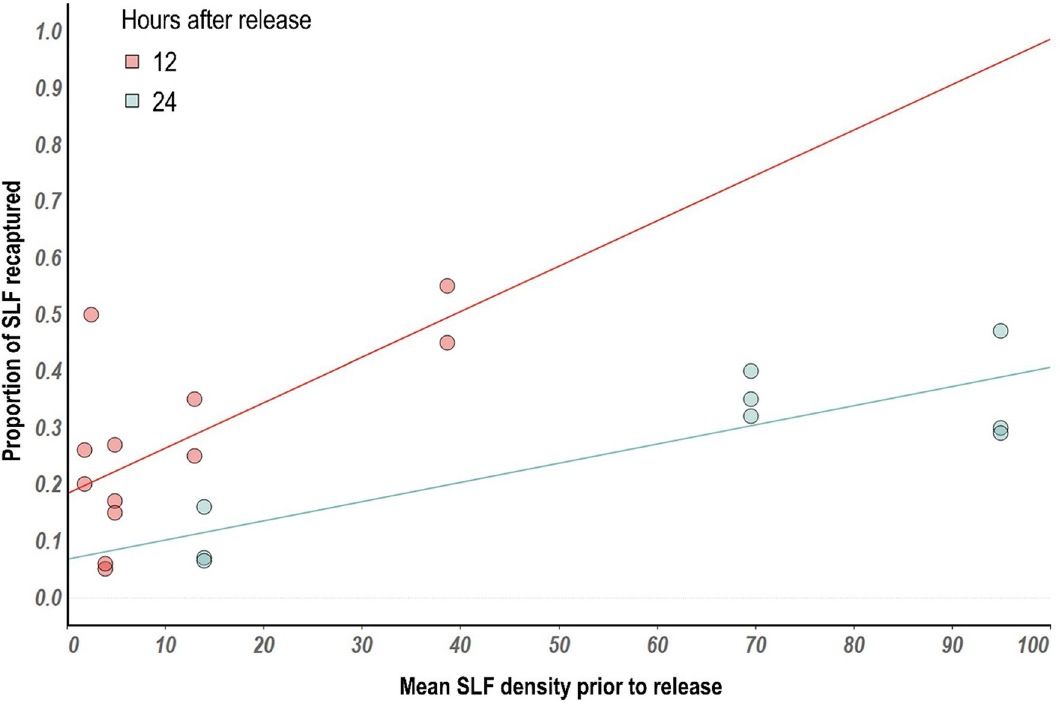
Figure 6. Relationship between mean spotted lanternfly density and proportion of SLF recapture after either 12 or 24